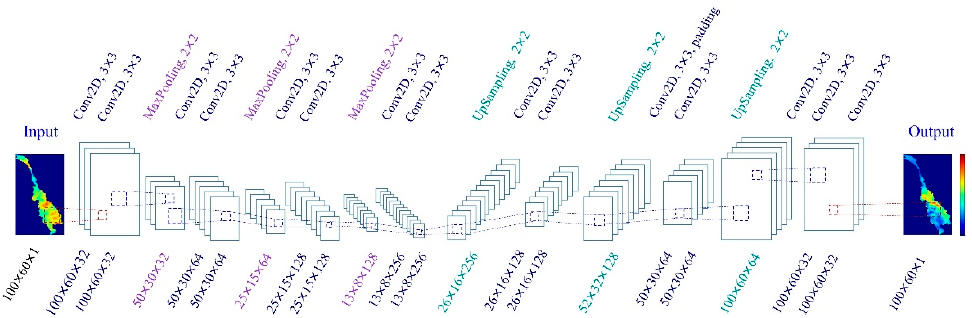
Figure 3. The architectural paradigm of the CAE model.